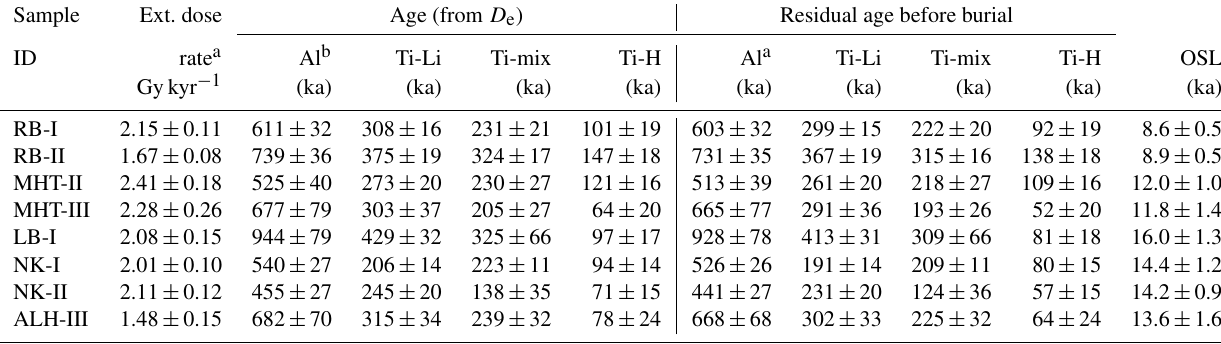
Table 3. External dose rates, ESR ages derived from D e , residual ages before burial and mean OSL ages for comparison. Sample